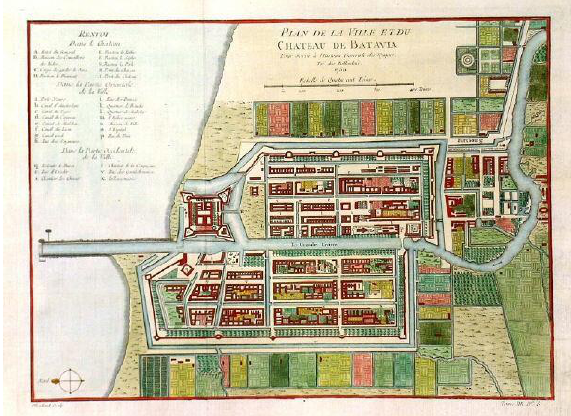
Figure 11. Batavia’s spatial configuration map circa 1744 (Plan de la Ville et du Château Batavia, Jacques Nicolas).